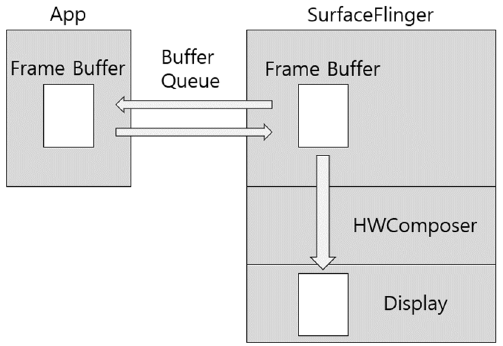
Figure 4. Process of composing and displaying an image by SurfaceFlinger.